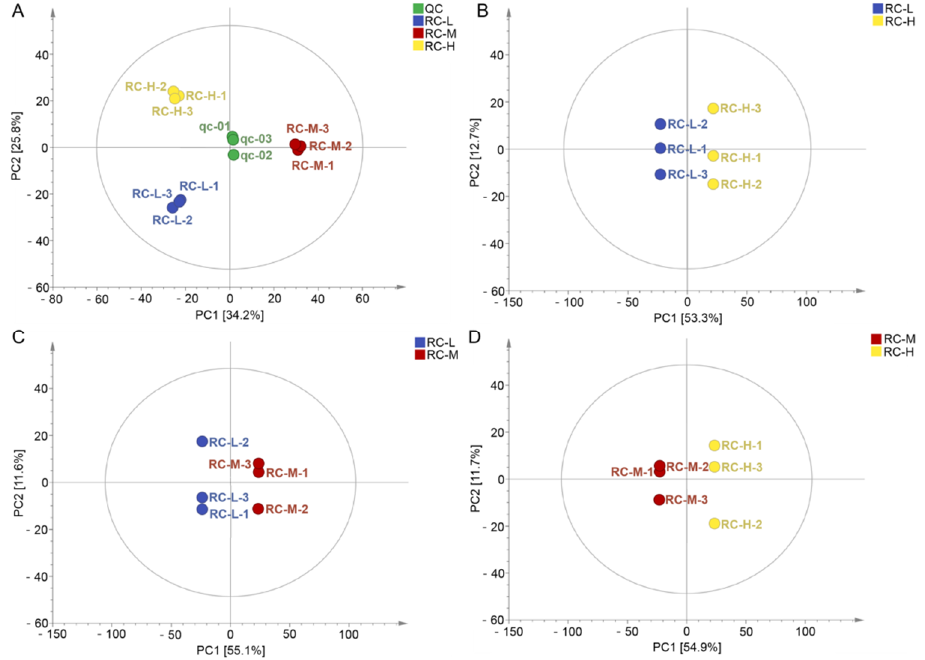
Figure 5. Principal component analysis (PCA) plots and orthogonal projections to latent structures discriminant analysis (OPLS-DA) of Rhodiola crenulata (RC-L, altitude of 3933 m; RC-M, altitude of 4249 m; RC-H, altitude of 4531 m) with three repeats for respective sample. ( A ): Two-dimensional scatter plot of the PCA for RC-L, RC-M, RC-H, and the quality control (QC). The QC was a mixture of RC-L, RC-M, and RC-H; ( B – D ): Score scatter plots of the OPLS-DA for RC-H vs. RC-L, RC-M vs. RC-L and RC-H vs. RC-M.